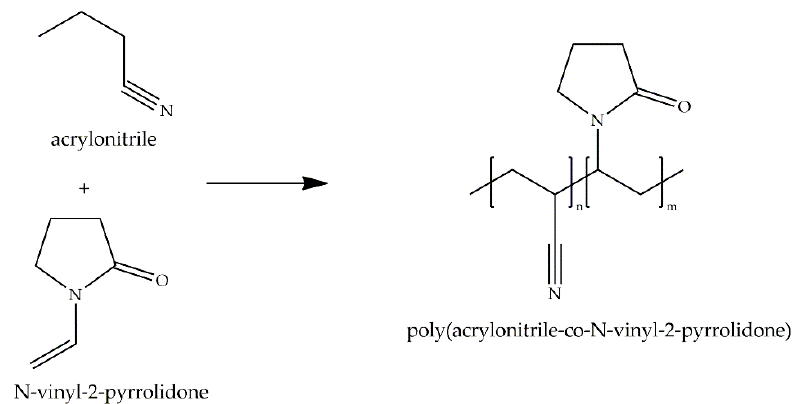
Figure 23. Molecular structure of poly(acrylonitrile)- co - N -2-vinyl-pyrrolidone (PANcNVP) and its monomers.